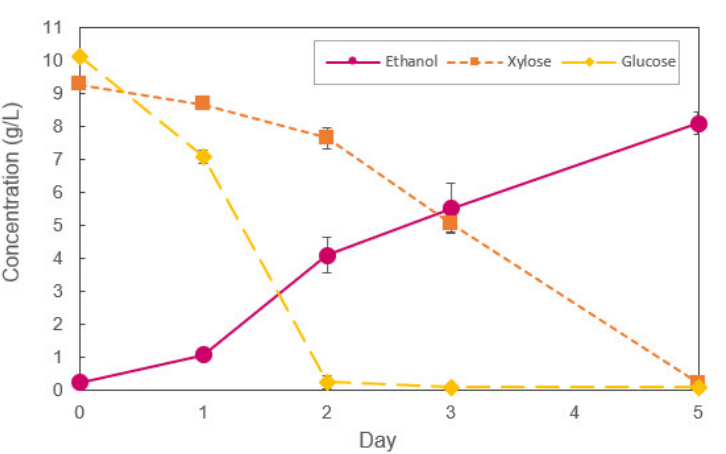
Figure 4. Sugar consumption and ethanol formation during the cofermentation of glucose and xylose by F. moniliforme BIOTECH 3170.